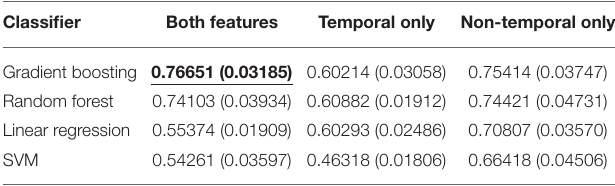
TABLE 3 | Average and standard deviation (SD) of AUC-ROC score for ICU readmission prediction results using shallow classifiers with temporal features only, non-temporal features only, and both types of